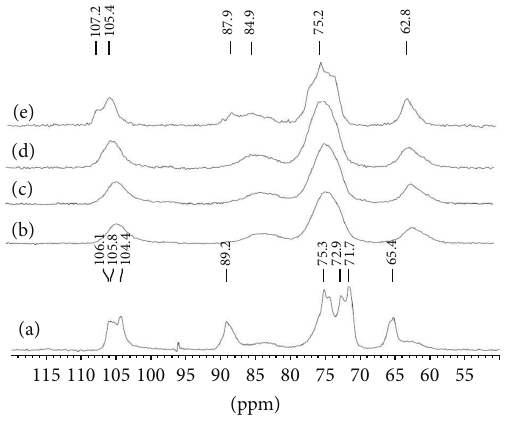
Figure 7: 13 C CP-MAS spectra of films, (a) virgin fibers, (b) AmimCl, (c) BmimCl, (d) EmimCl, and (e) EmimAc.